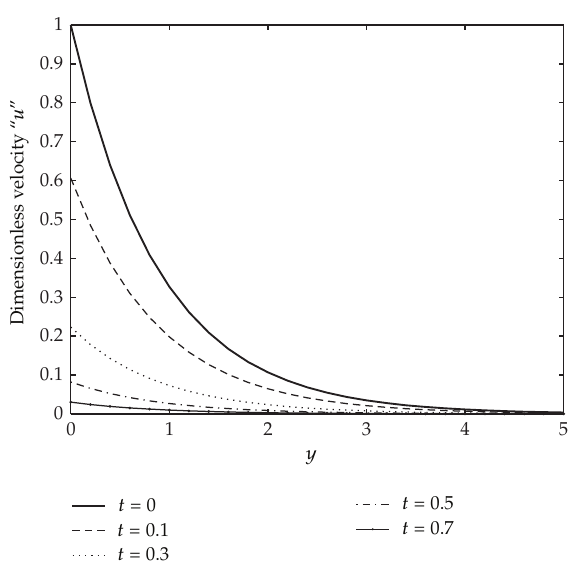
Figure 5: Conditional symmetry solution (cid:3) 5.15 (cid:4) varying t when γ (cid:8) 0 . 2, γ 1 (cid:8) 0 . 1, β (cid:8) 6, β 1 (cid:8) 0 . 5, and α (cid:8) 1 are